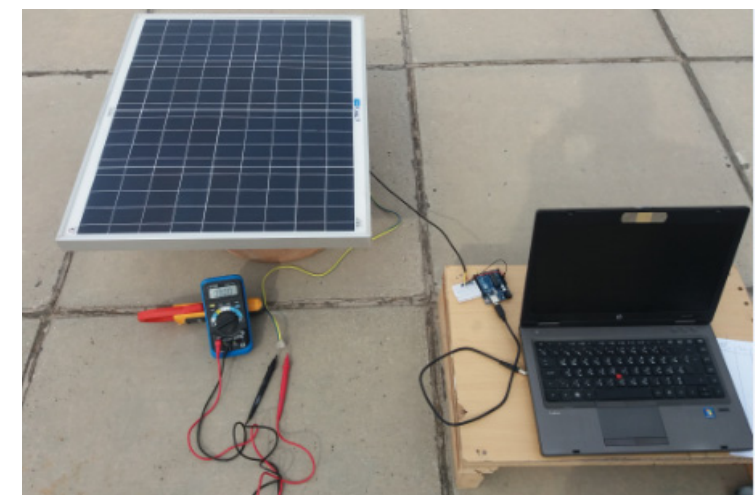
Figure 8. Experimental setup. Table 3. The measurement results.